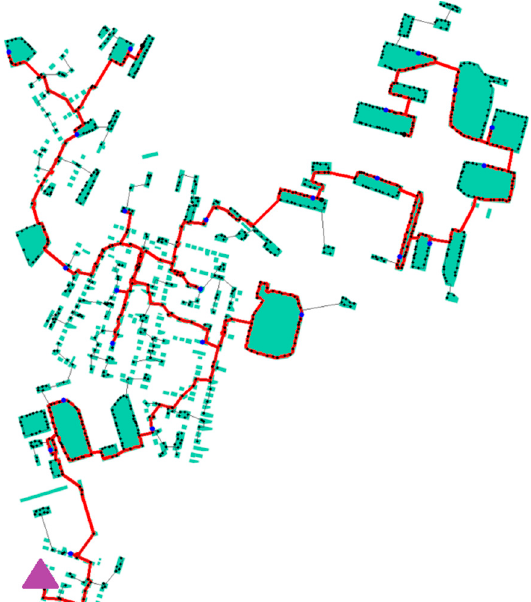
Figure 5 Network image of Varaždin industrial area in DiNeMo. Figure 5. Network image of Varaždin industrial area in